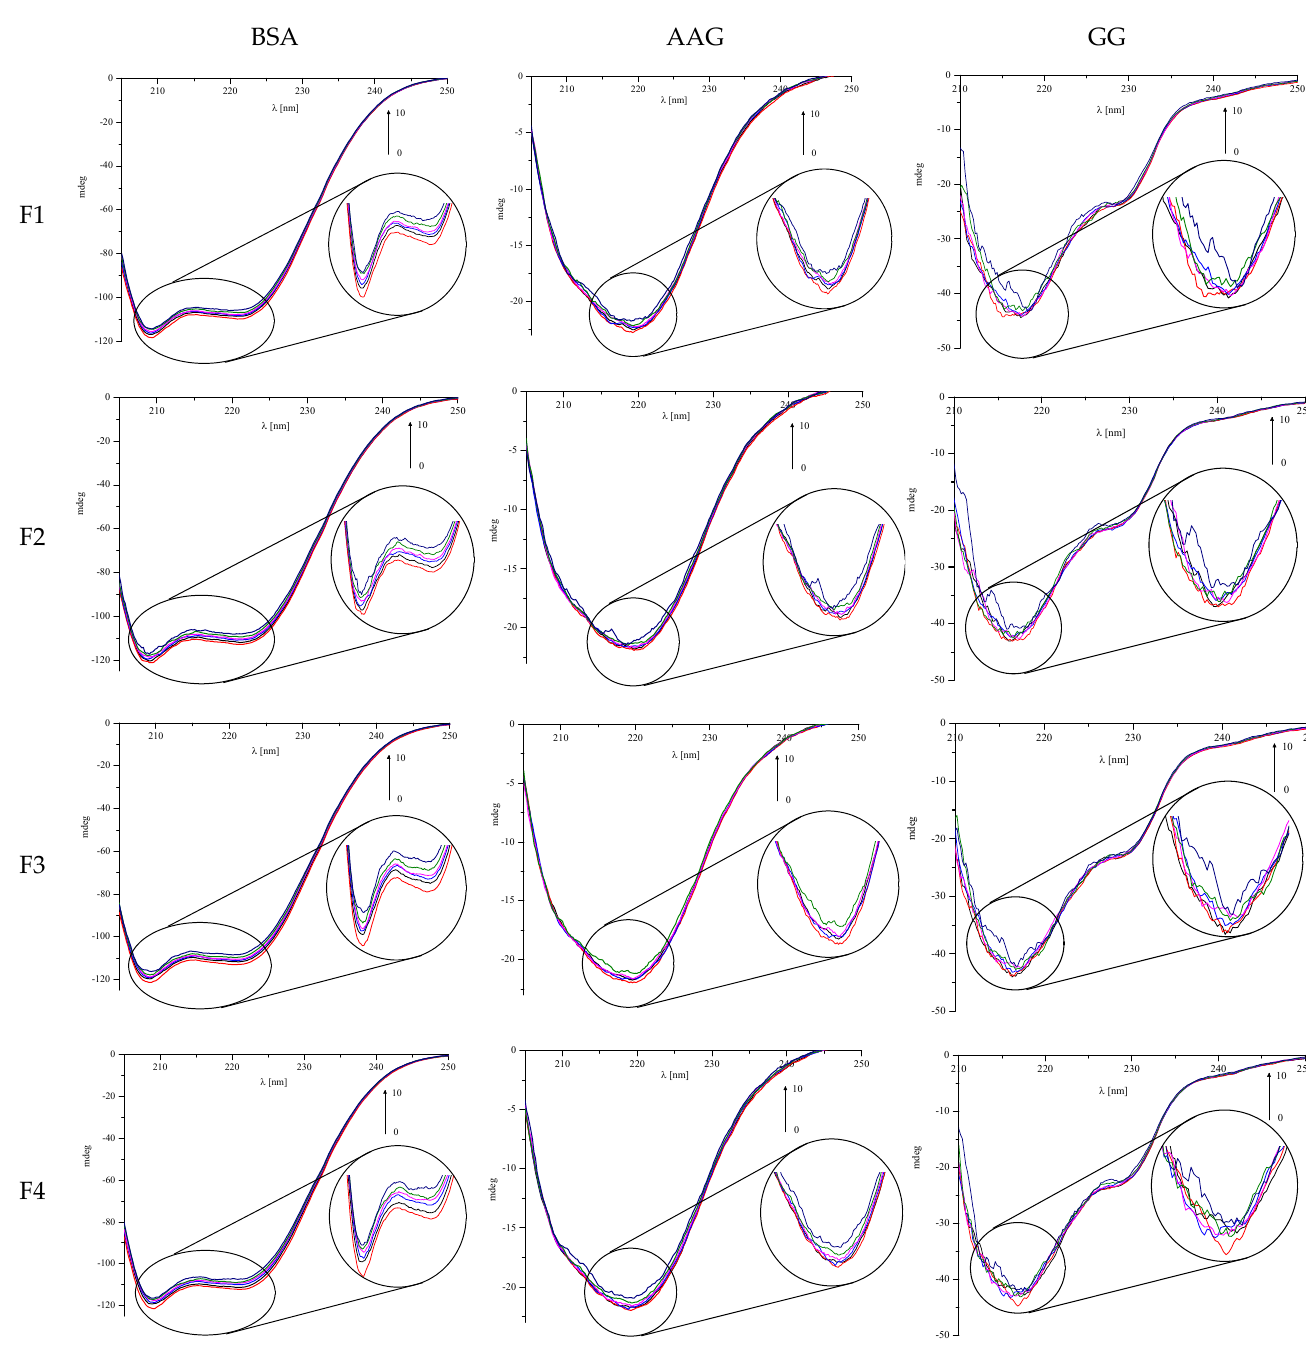
Figure 4. Circular dichroism spectra of BSA, AAG, and GG in the absence and presence of analyzed phthalimide derivatives F1, F2, F3, and F4.